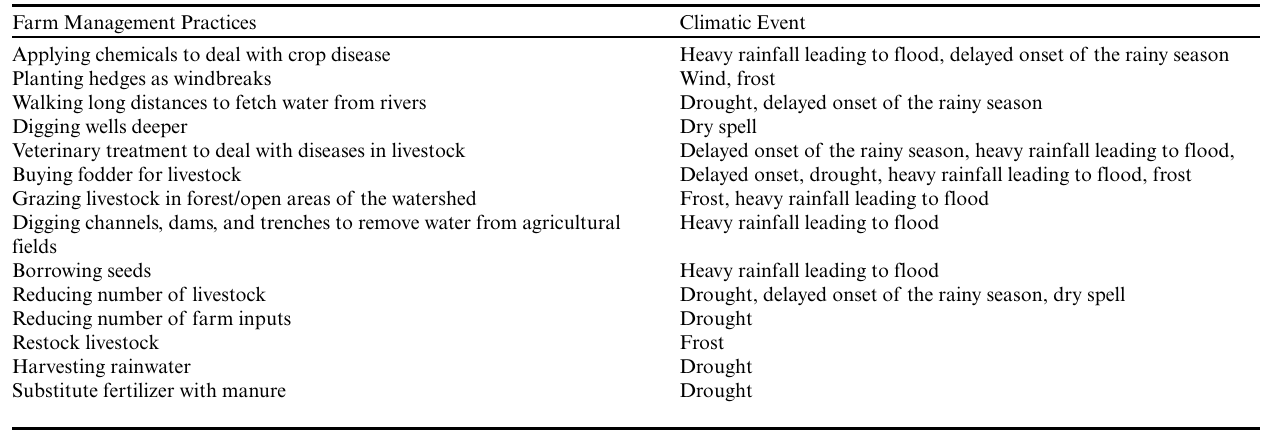
Table 2 . Farm management practices currently used by farmers to deal with climate variability and